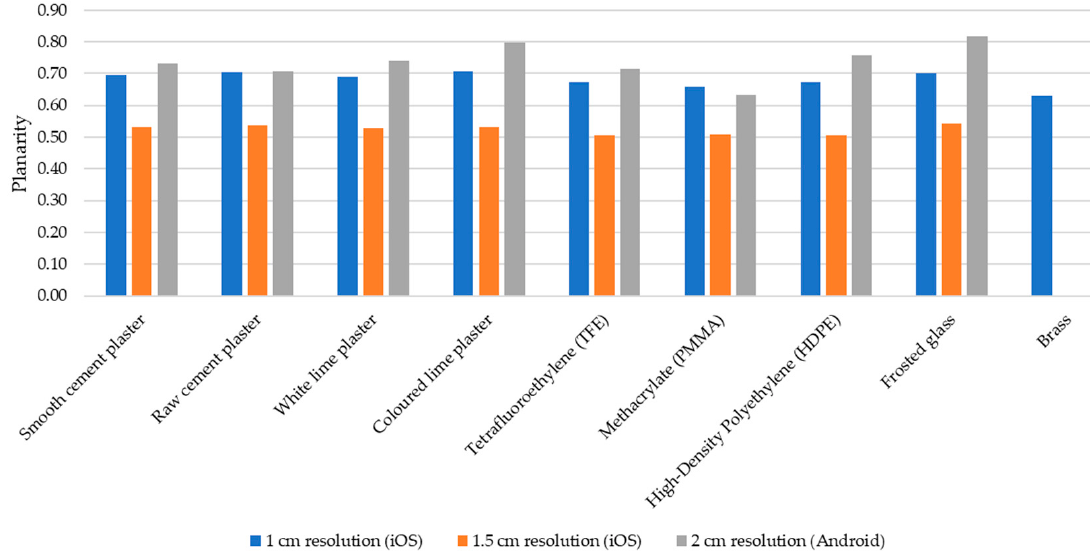
Figure 10. Comparison of mean planarity values for samples scanned at a distance of 0.5 m. Table 3. R2 values obtained by linear regression between sample albedo and surface variation val- ues.